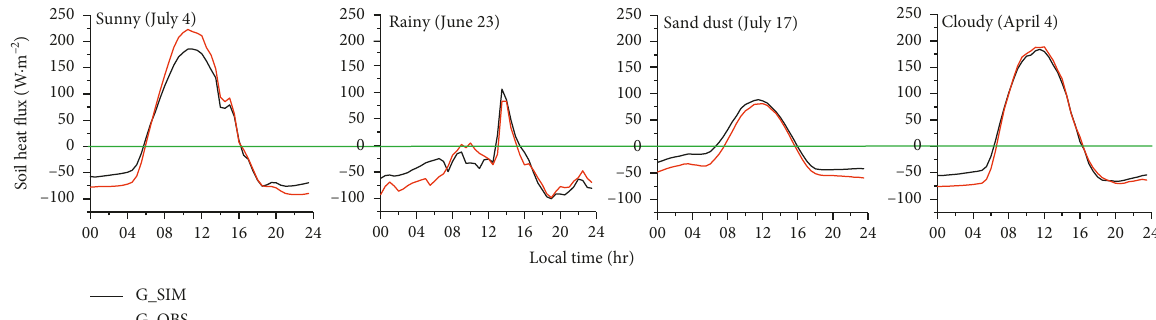
Figure 10: Contrast curve between the simulated (black) and observed (red) soil heat flux ( G station in 2014.